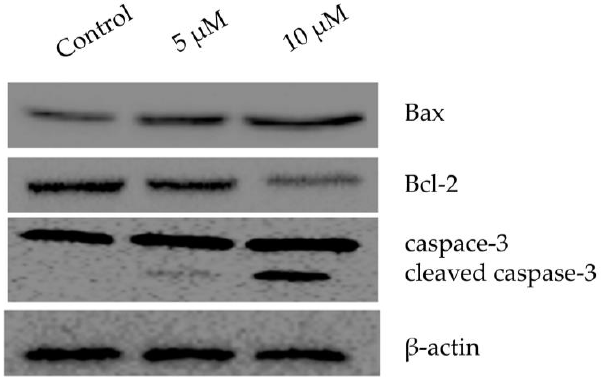
Figure 5. Effects of chlorojanerin on the protein expression of Bax, Bcl-2 and caspase-3 in human lung A549 carcinoma cells. Cells were treated with or without increasing concentrations of chlorojanerin for 24 h. Western blot analysis was carried out using specific antibody for each target gene while β -actin was served as an internal control.